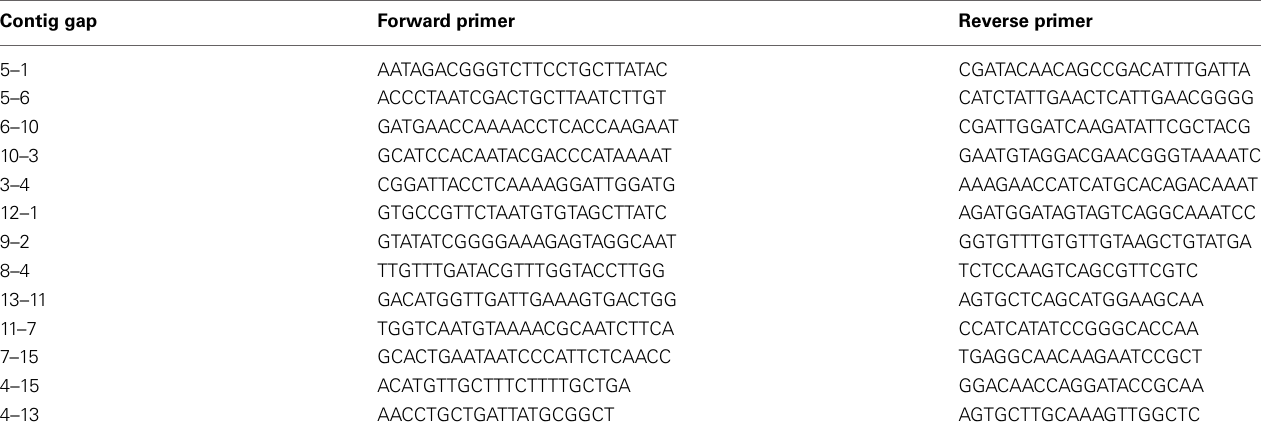
Table 2 | Specific Primers targeting identified contig gaps for amplification. Contig gap Forward primer Reverse